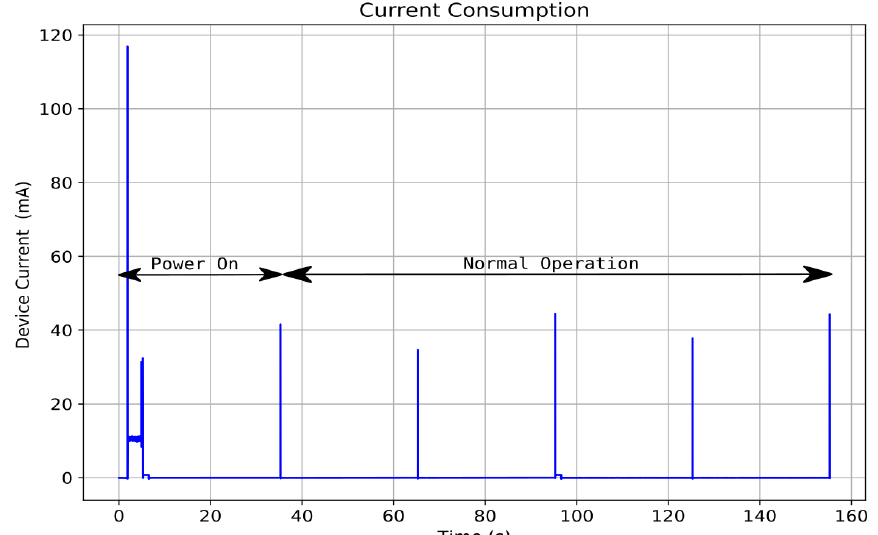
Figure 3. Current consumption on CSCG Tag.